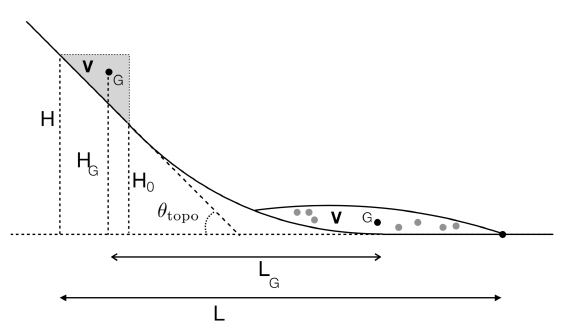
Figure 1. Granular mass and model topography over which the mass is released, left to flow and come to